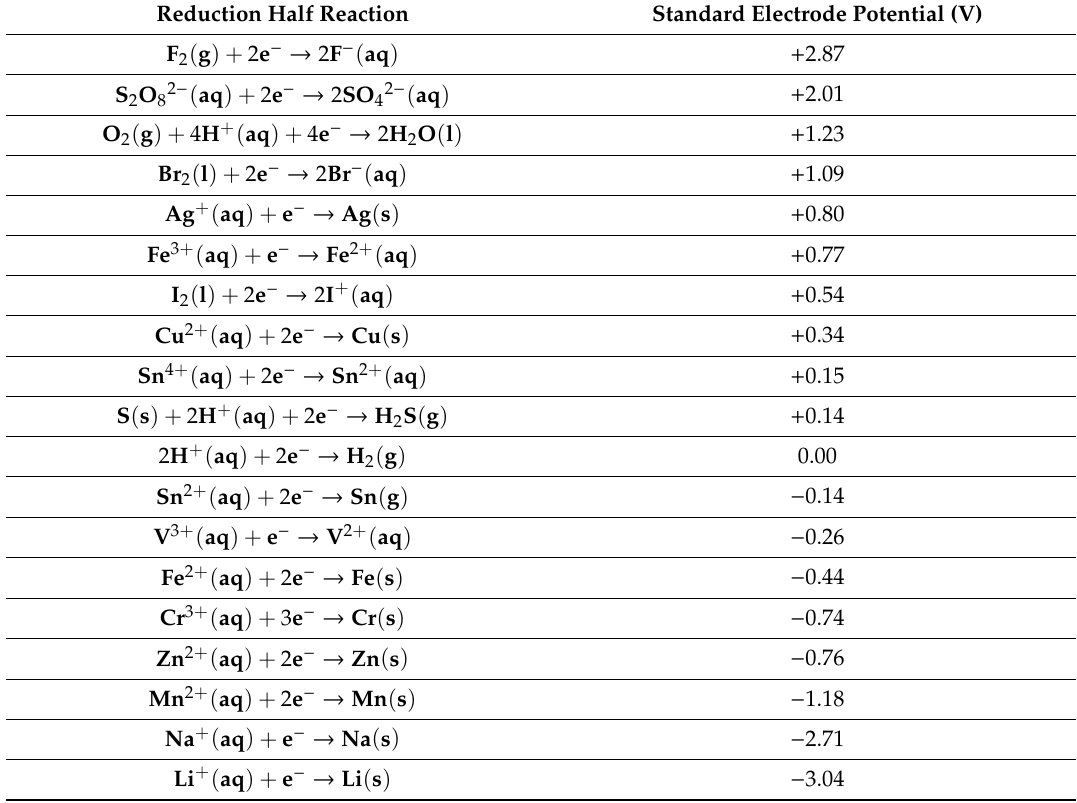
Table 6. List of standard reduction potential of chemicals in battery energy storage (BES)